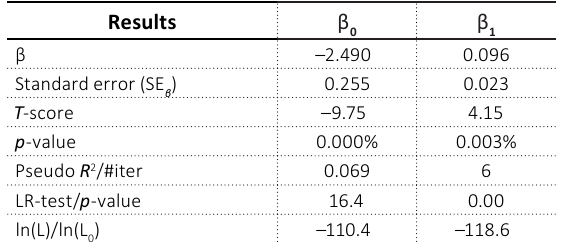
Table 2. Results of logit curve regression of loss